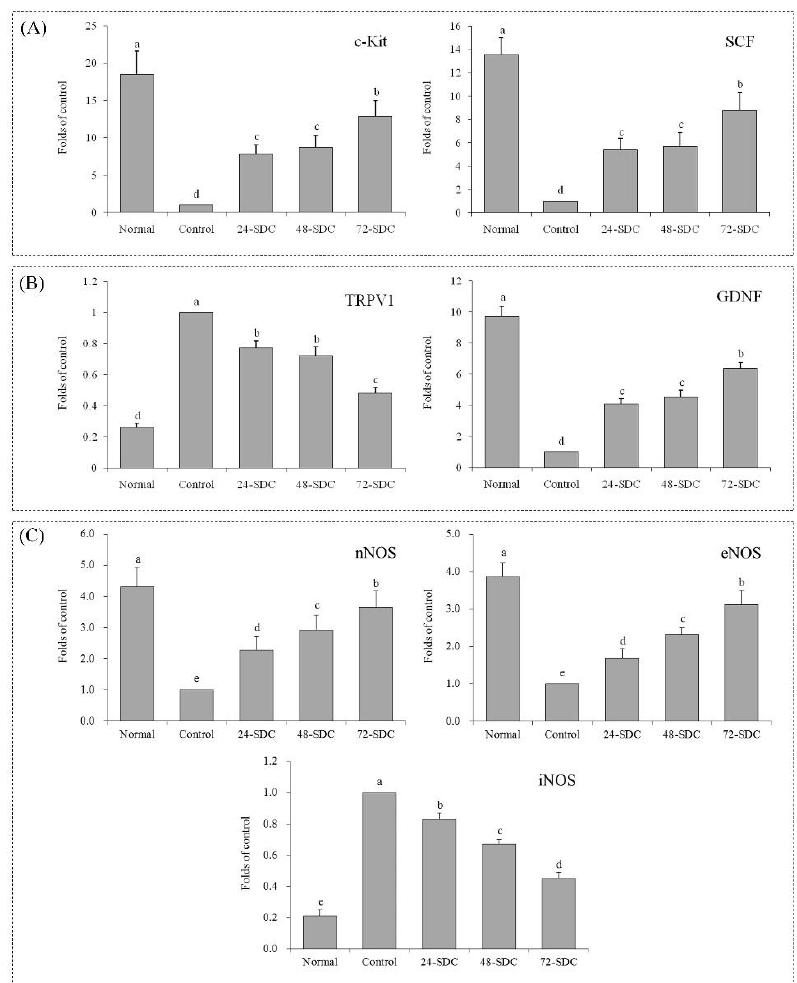
Figure 6. Messenger RNA (mRNA) expression levels of ( A ) c-Kit and stem-cell factor ( SCF ); ( B ) : transient receptor potential cation channel subfamily V member 1 ( TRPV1 ) and glial cell-derived neurotrophic factor ( GDNF ); ( C ) neuronal nitric oxide synthase ( nNOS ), endothelial nitric oxide synthase ( eNOS ), and ; iNOS : inducible nitric oxide synthase ( iNOS ) in the small-intestine tissue of mice. Values presented are means ± standard deviation ( n = 3). Different letters indicate significant differences ( p < 0.05) between each group, and the same letters indicate that there is no significant difference ( p > 0.05) between each group according to Tukey’s test for multiple comparisons. 24-SDC: 24-h-fermented Shuidouchi; 48-SDC: 48-h-fermented Shuidouchi; 72-SDC: 72-h-fermented Shuidouchi.